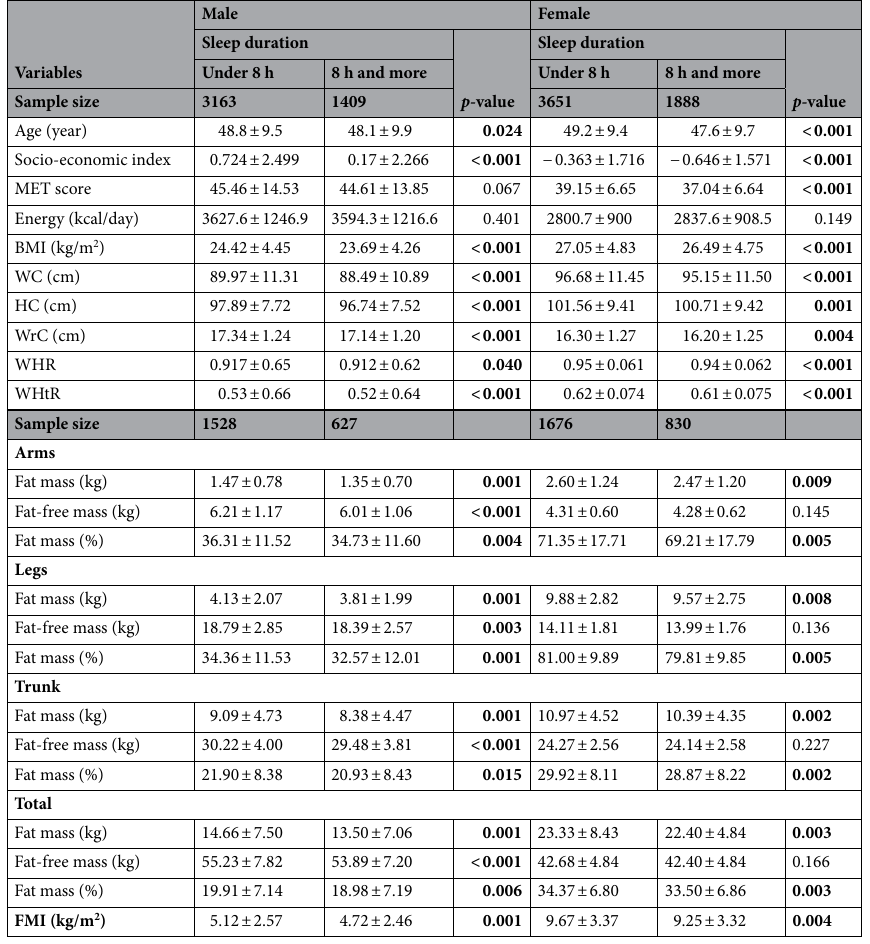
Table 1. The comparison of anthropometric and body composition data between sleep groups according to gender. BMI body mass index, WC waist circumferences, HC hip circumferences, WrC wrist circumferences, WHR waist to hip ratio, WHtR waist to height ratio, FMI fat mass index. Bold values are less than 0.05 and are statistically